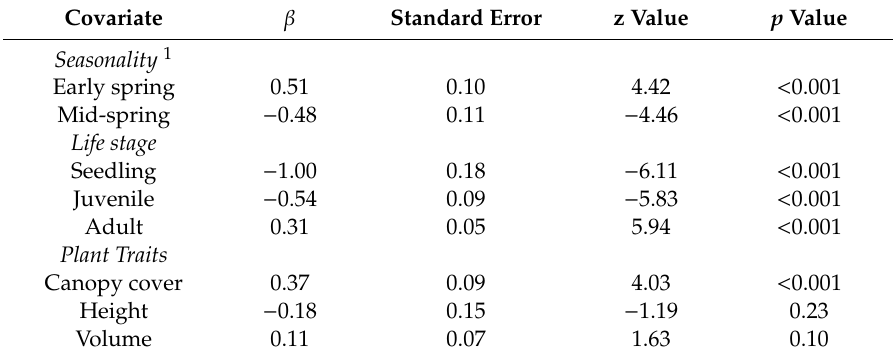
Table 1. Standardized coe ffi cients of the global Poisson generalized linear model developed to determine relationships between count of queen butterfly eggs oviposited on Mojave milkweed host plants and covariates